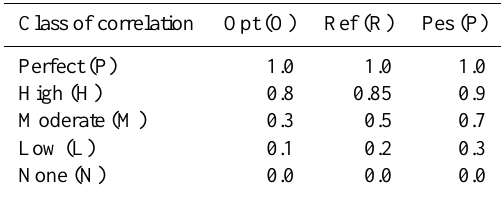
Table 3. Values of spatial correlation coefficients for three robust- ness